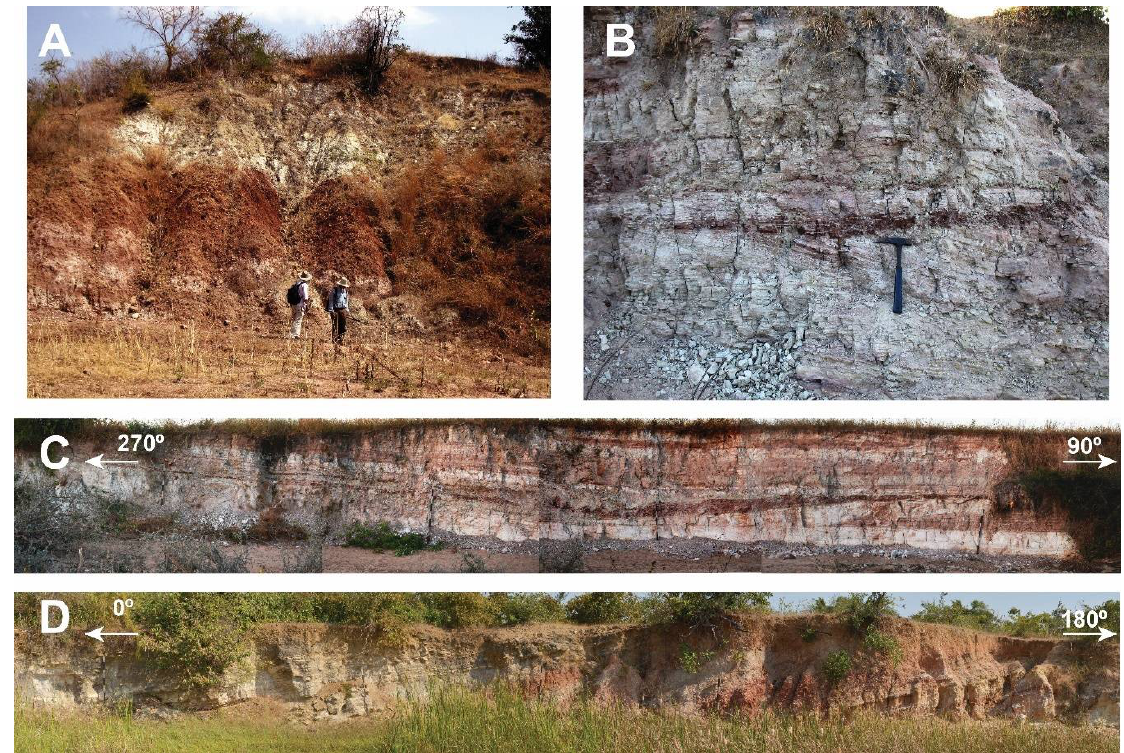
Figure 2. ( A ) Field photograph showing fine-grained sheet sand body overlying a thicker mudstone unit within the Yerrapalli formation, near Salpalabaigudem village. ( B ) Field photograph showing medium- to coarse-grained sandstone beds intercalated with minor red mudstone beds near Salpalabaigudem village within the Bhimaram formation (hammer length = 37 cm). ( C ) Field photograph of Maleri formation showing very-fine- to medium-grained multi-storied sheet sandstone body composed of alternating sandstone and mudstone beds within the Maleri formation near Aklapalli village. ( D ) Field photograph showing very-coarse- to fine-grained sandstone bodies within the Dharmaram formation alternating with mudstone units, near Paikashigudem village. Scale bar = 1.5 m.